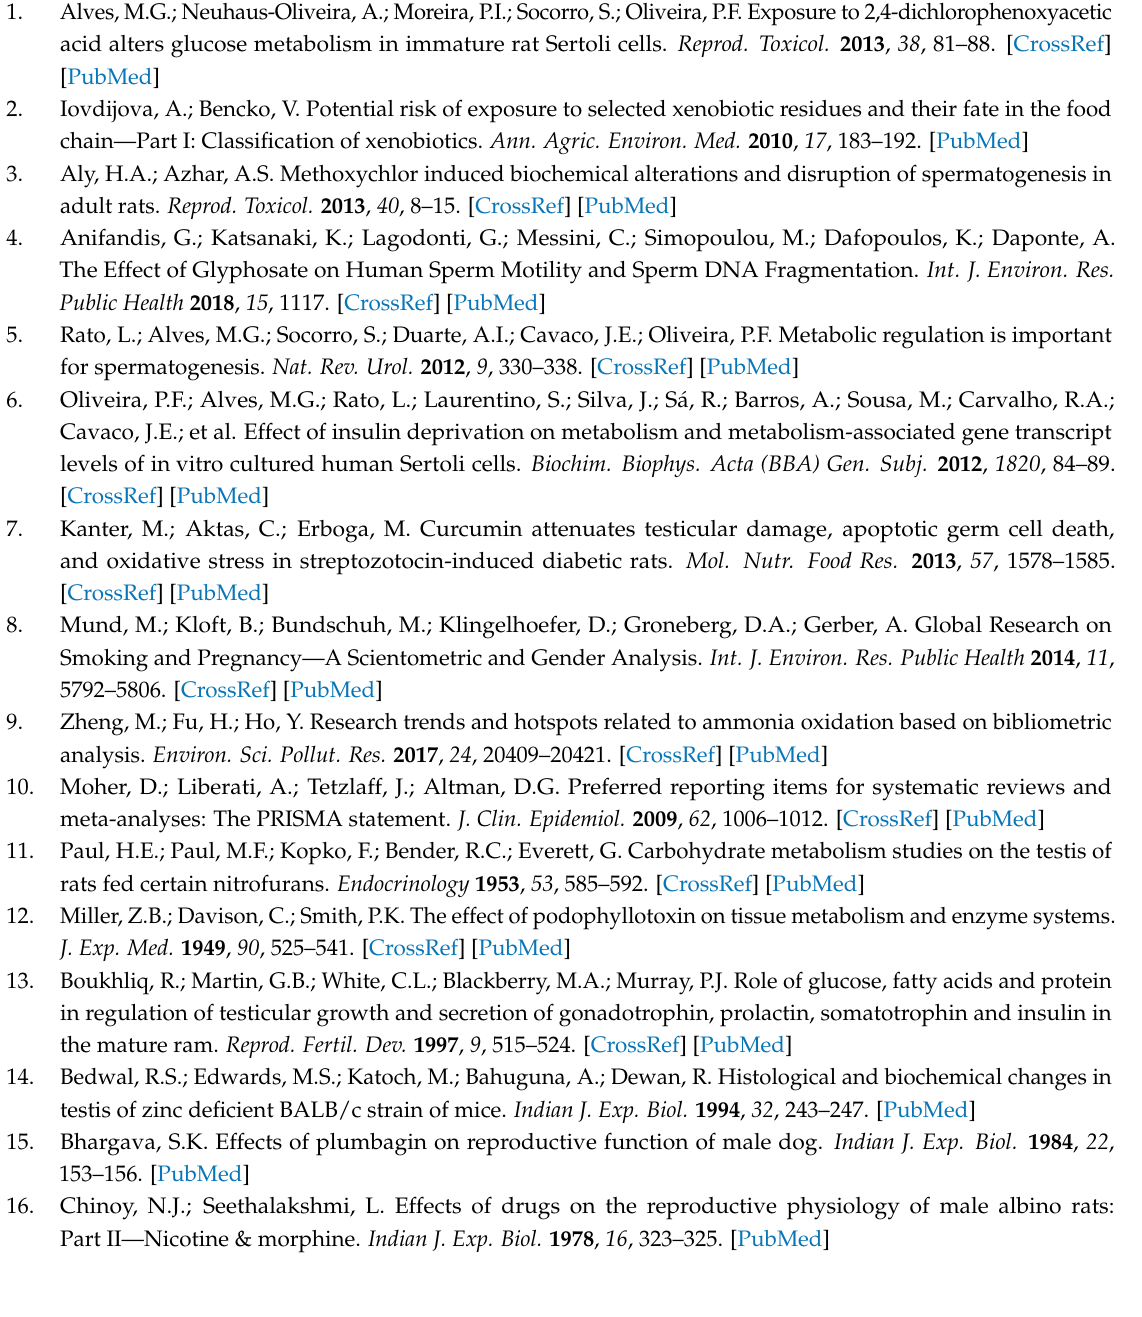
Table S1: The list of 165 eligible